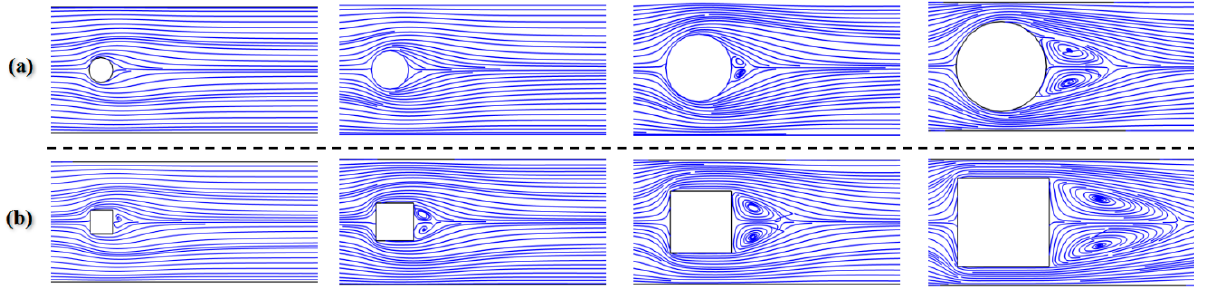
Figure 20. The streamlines of ( a ) cylinder obstacles and ( b ) square obstacles under different Ω values when Re = 50.